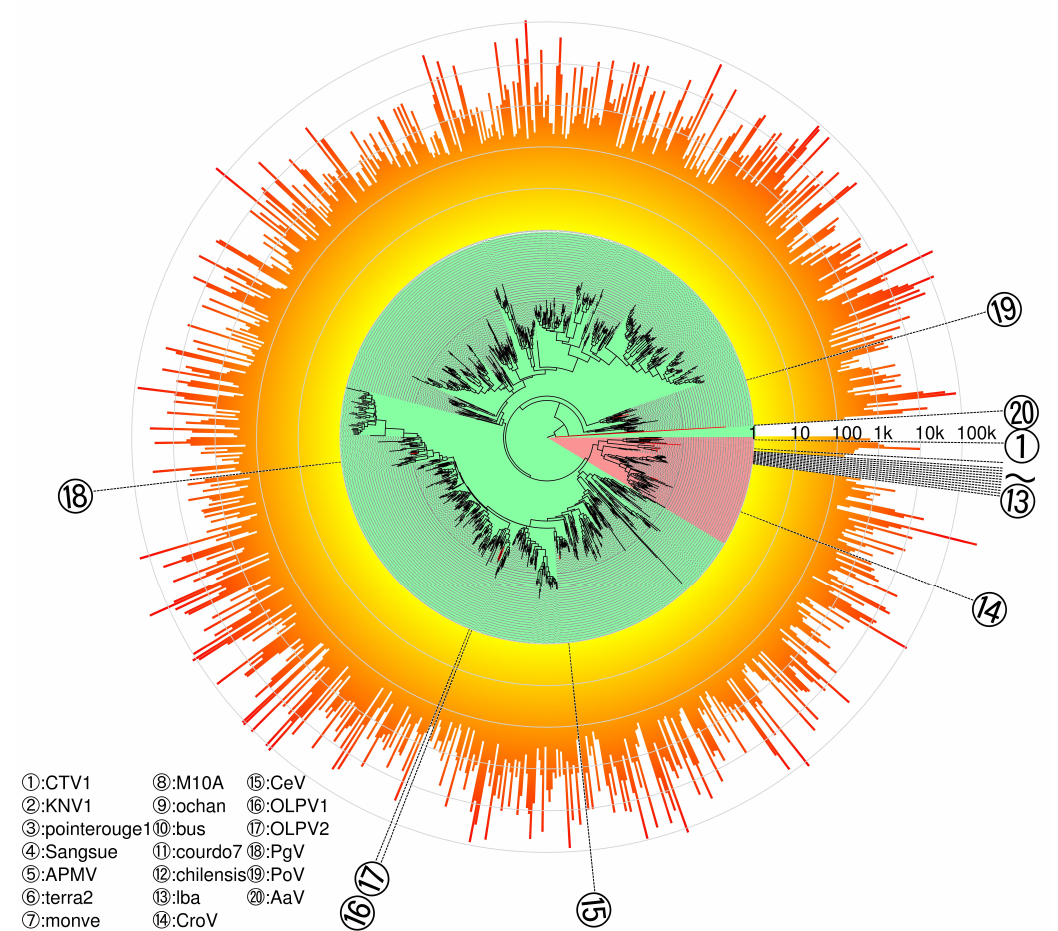
Figure 5. Phylogenetic tree of PolB meta-barcodes. Maximum-likelihood phylogenetic of Megaviridae PolB meta-barcodes with additional known Megaviridae sequences. Branch lengths are scaled. The tree is rooted by nine Phycodnaviridae sequences, which are not shown in this figure. Leaves are either meta-barcodes (black) or reference Megaviridae PolBs (red). Background colors of the tree indicate either putative Megamimivirinae (pink) or putative Mesomimivirinae (green). Lengths of orange bars outside the tree represent OTU abundances (number of reads, log scaled). CTV1: Catovirus